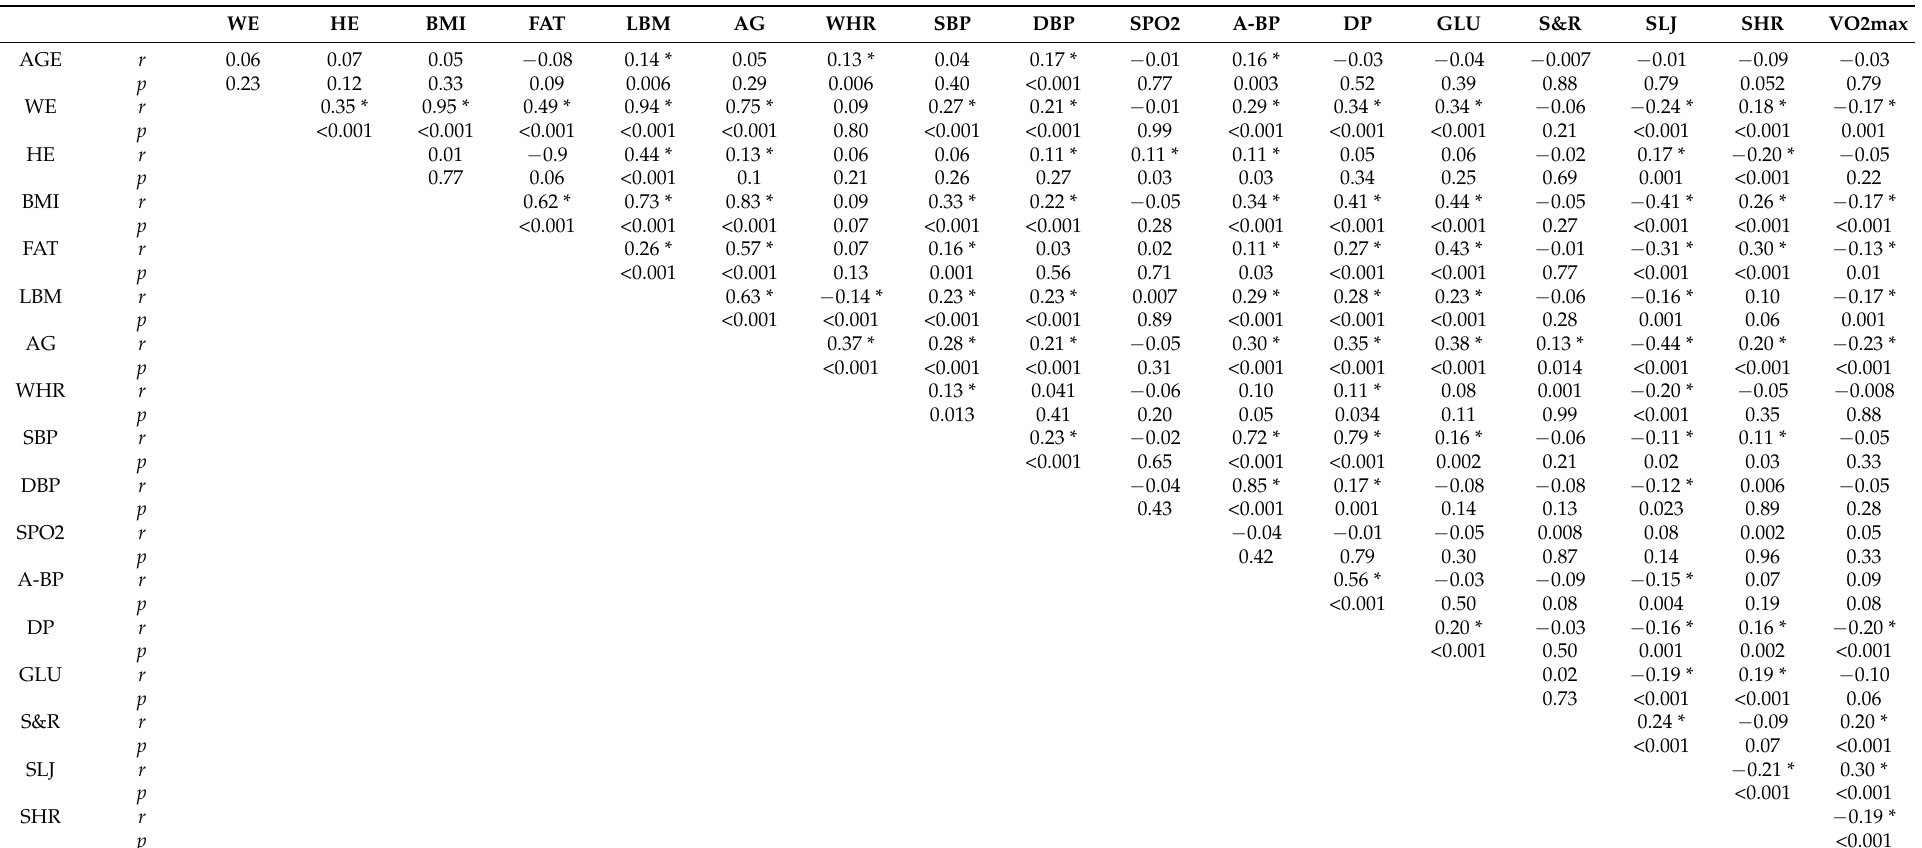
Table 3. Correlation matrix: correlation between